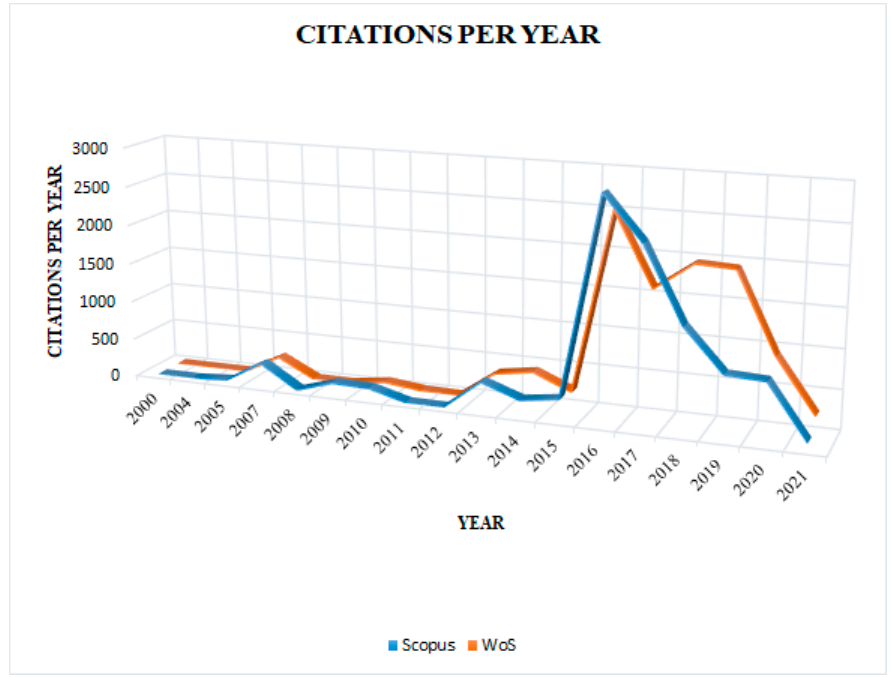
Figure 9. The number of citations per year.